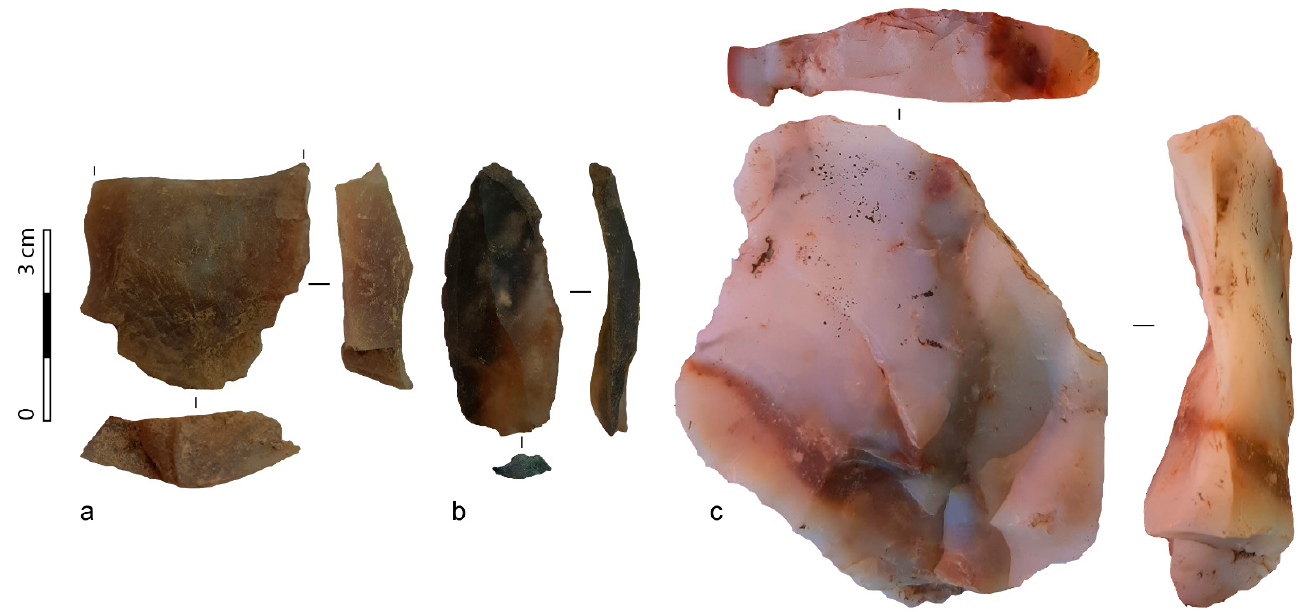
Figure 6. Lojanik 1, lithic artefacts: ( a ) fragment of blade detached with hard hammer; ( b ) potentially Levallois laminar blank; ( c ) core tablet from Geo-trench 1.